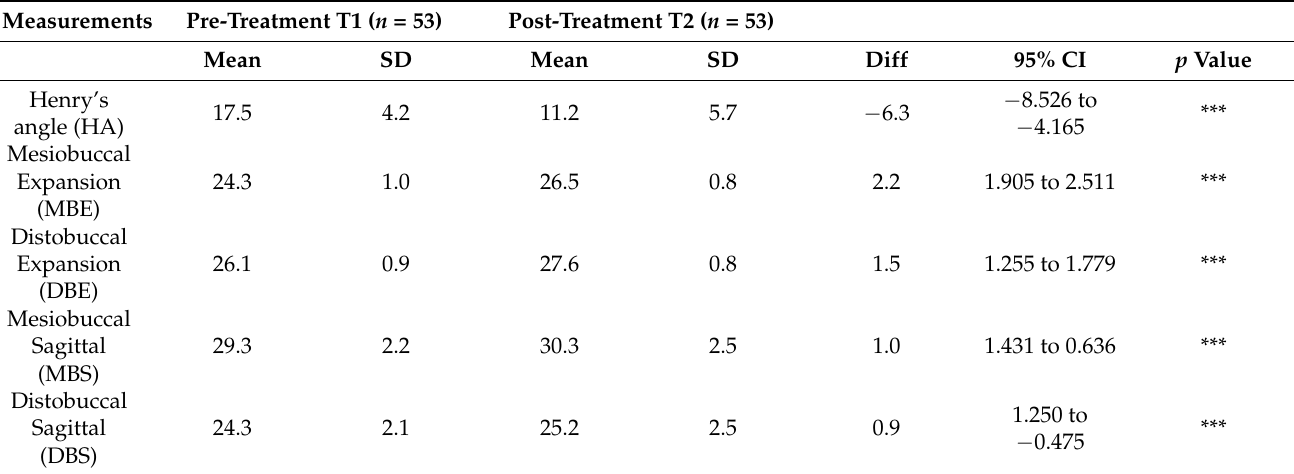
Table 1. Descriptive statistics and statistical comparisons of T2-T1 changes (Paired t